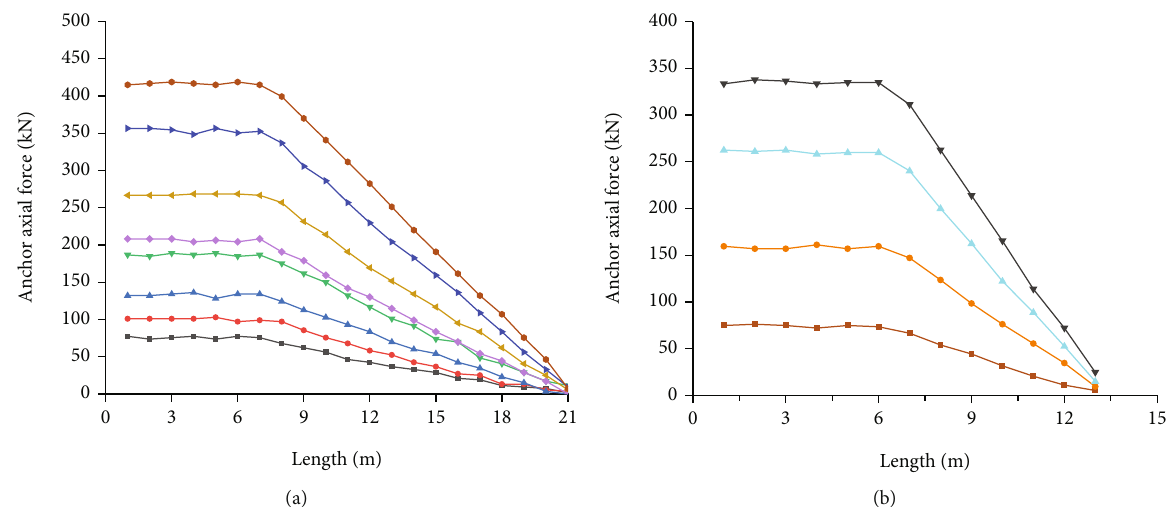
Figure 12: Distribution curve of axial force of anchor. (a) Axial force distribution curve of fi rst-row anchor. (b) Distribution curve of axial force of second-row